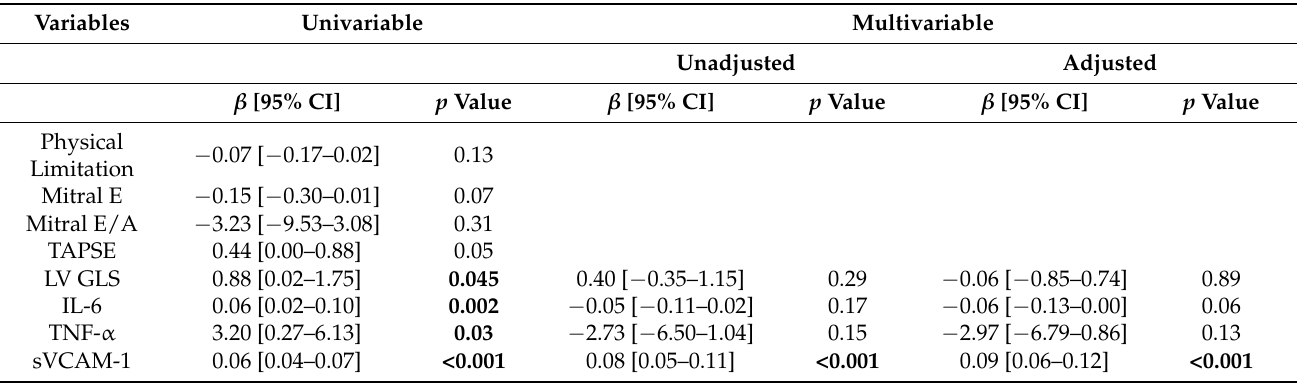
Table 4. Univariable and multivariable liner regression analyses for mean